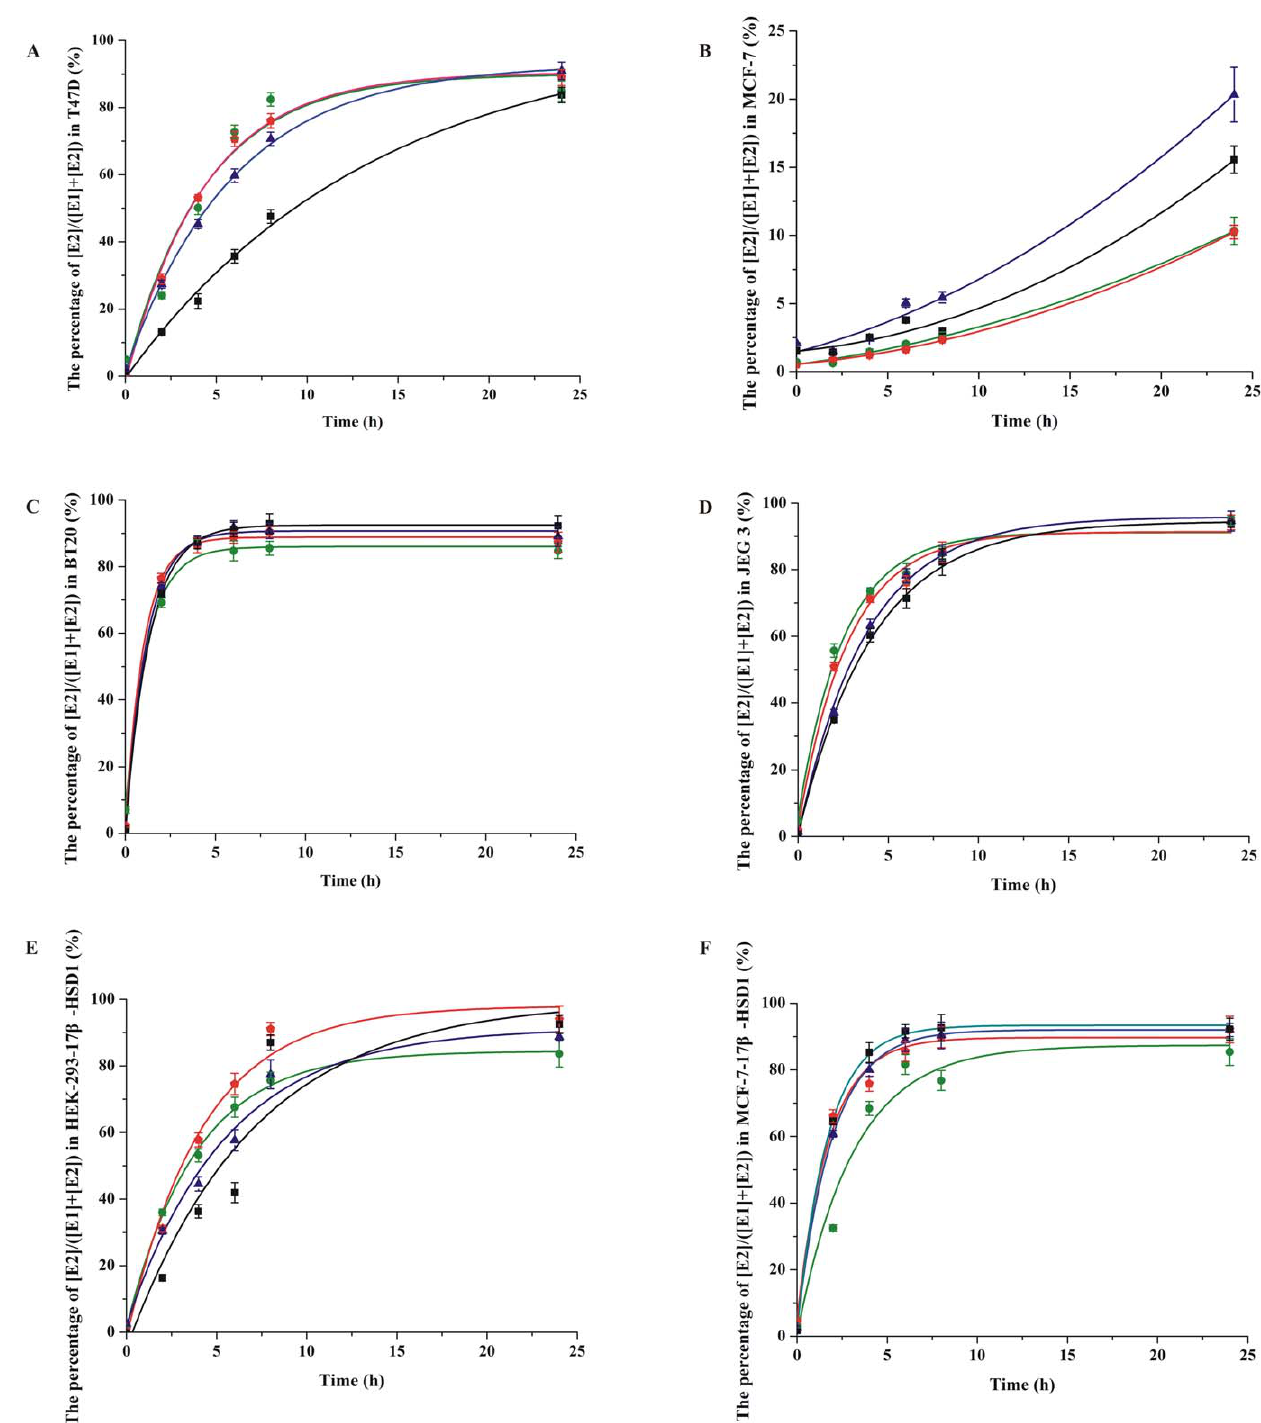
Figure 1. The conversion of E1 to E2 in T47D, MCF-7, BT 20, JEG 3, HEK-293-17 b -HSD1 and MCF-7-17 b -HSD1 cells. 50,000 cells were seeded onto 24-well plates, and different concentrations of E1 (0.01 m M, 0.05 m M, 0.1 m M and 0.3 m M) were added to dextran-coated charcoal treated medium. E2 production was evaluated every 0 h, 2 h, 4 h, 6 h, 8 h and 24 h. Choosing 0.01 m M, 0.05 m M, 0.1 m M and 0.3 m M E1 as the substrate are represented by green, red, blue and black lines respectively. Experiments were performed in duplicate, and all the data are fit to sigmoidal or exponential distribution (S.D. # 1%). doi:10.1371/journal.pone.0029835.g001 correlative with the expression of estrogen receptors. No not published), suggesting that 17 b -HSD1 is a dominant factor in significant changes have been found for E1 to E2 conversion the maintenance of this ratio compared to other 17 b -HSDs in after knocking down other 17 b -HSD reductive enzymes (data was breast cancer cells.